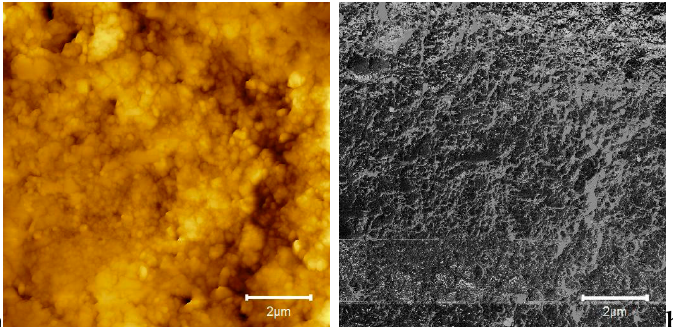
Figure 8. 10 × 10 µm 2D AFM images of the 3D-printed nanocomposite with 0.4% nanoTiO 2 : ( a ) topography; ( b ) phase contrast.